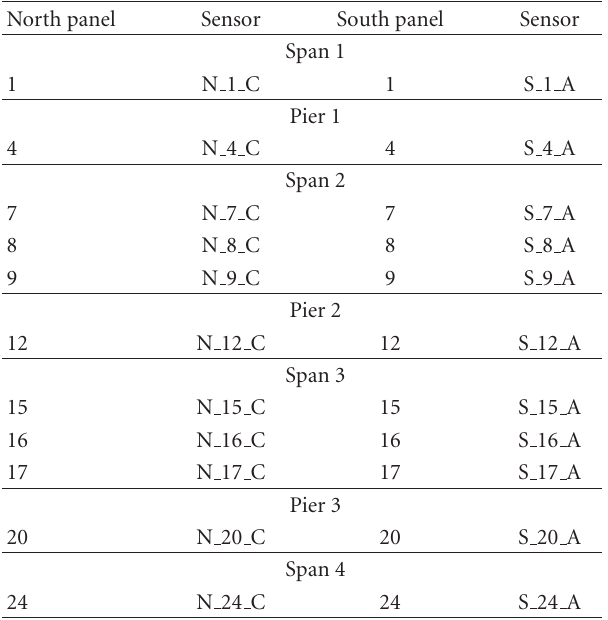
Table 4: Sensors used for stress monitoring at joints between panels (Group 3).